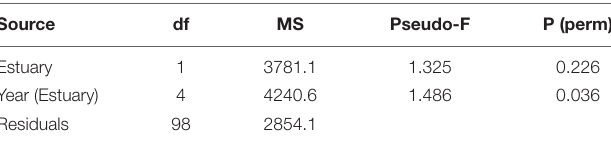
TABLE 3 | Results of the PERMANOVA analysis comparing cockle shell lengths between years (fixed, 3 levels: 2015, 2018, and 2019) nested in estuaries (fixed, 2 levels: Tagus and